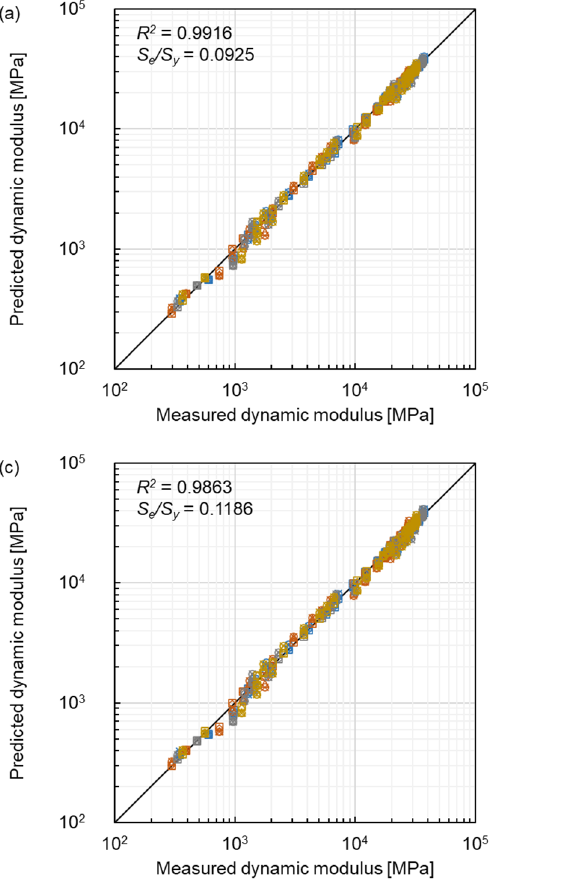
Figure 14. Comparison between measured dynamic modulus and predicted dynamic modulus of three master curve models: ( a ) SLS model, ( b ) GLS model and ( c ) CAM model. three master curve models: ( a ) SLS model, ( b ) GLS model and ( c ) CAM